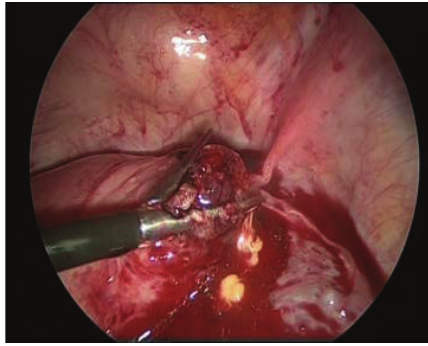
Figure 1: Laparoscopic findings showing a ruptured right uterine cornual ectopic pregnancy with hemoperitoneum.